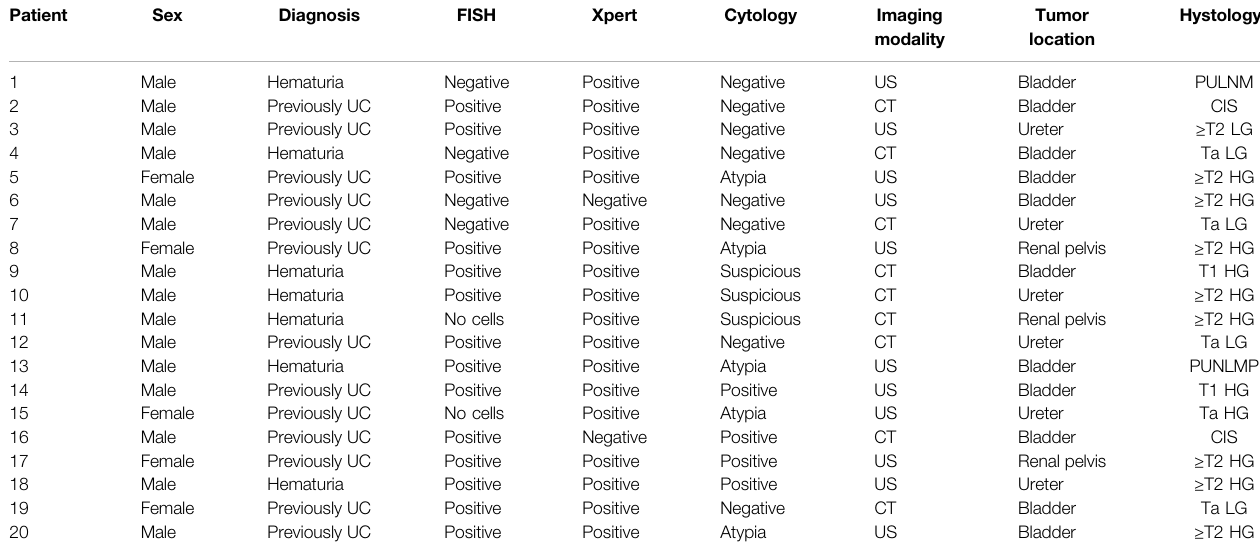
TABLE 2 | Sex, diagnosis, FISH, Xpert, cytology, imaging modality [US (ultrasound) and CT (computed tomography)], tumor location, and histology [a staging of tumor: PUNLM (papillary urothelial neoplasm of low malignant potential), CIS (carcinoma in situ ), and Ta, T1, and ≥ T2; HG = high grade; LG = low grade].